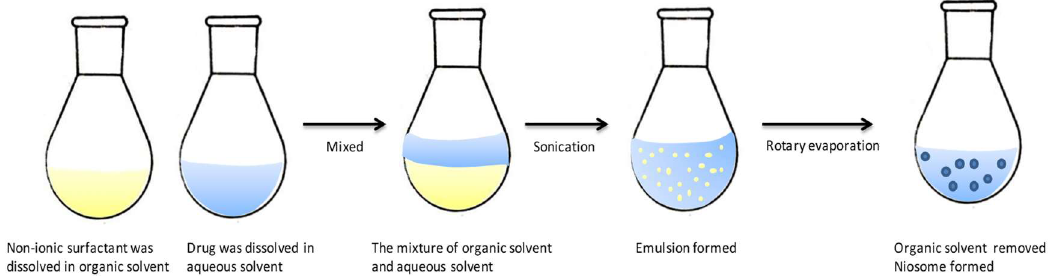
Figure 4. Preparation of niosomes by the reversed phase evaporation method. Reproduced with permission from [13], published by Elsevier, 2014.